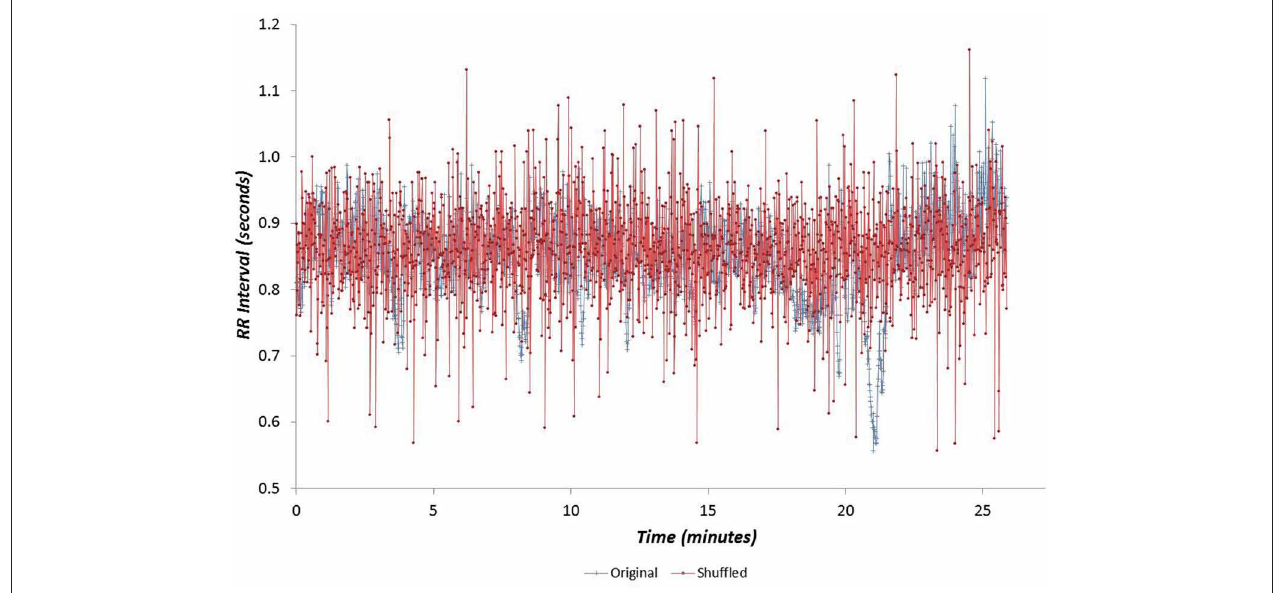
FIGURE 2 | Example cardiac interval (RR) time-series for the Night period, shown with the same data following data shuffling.